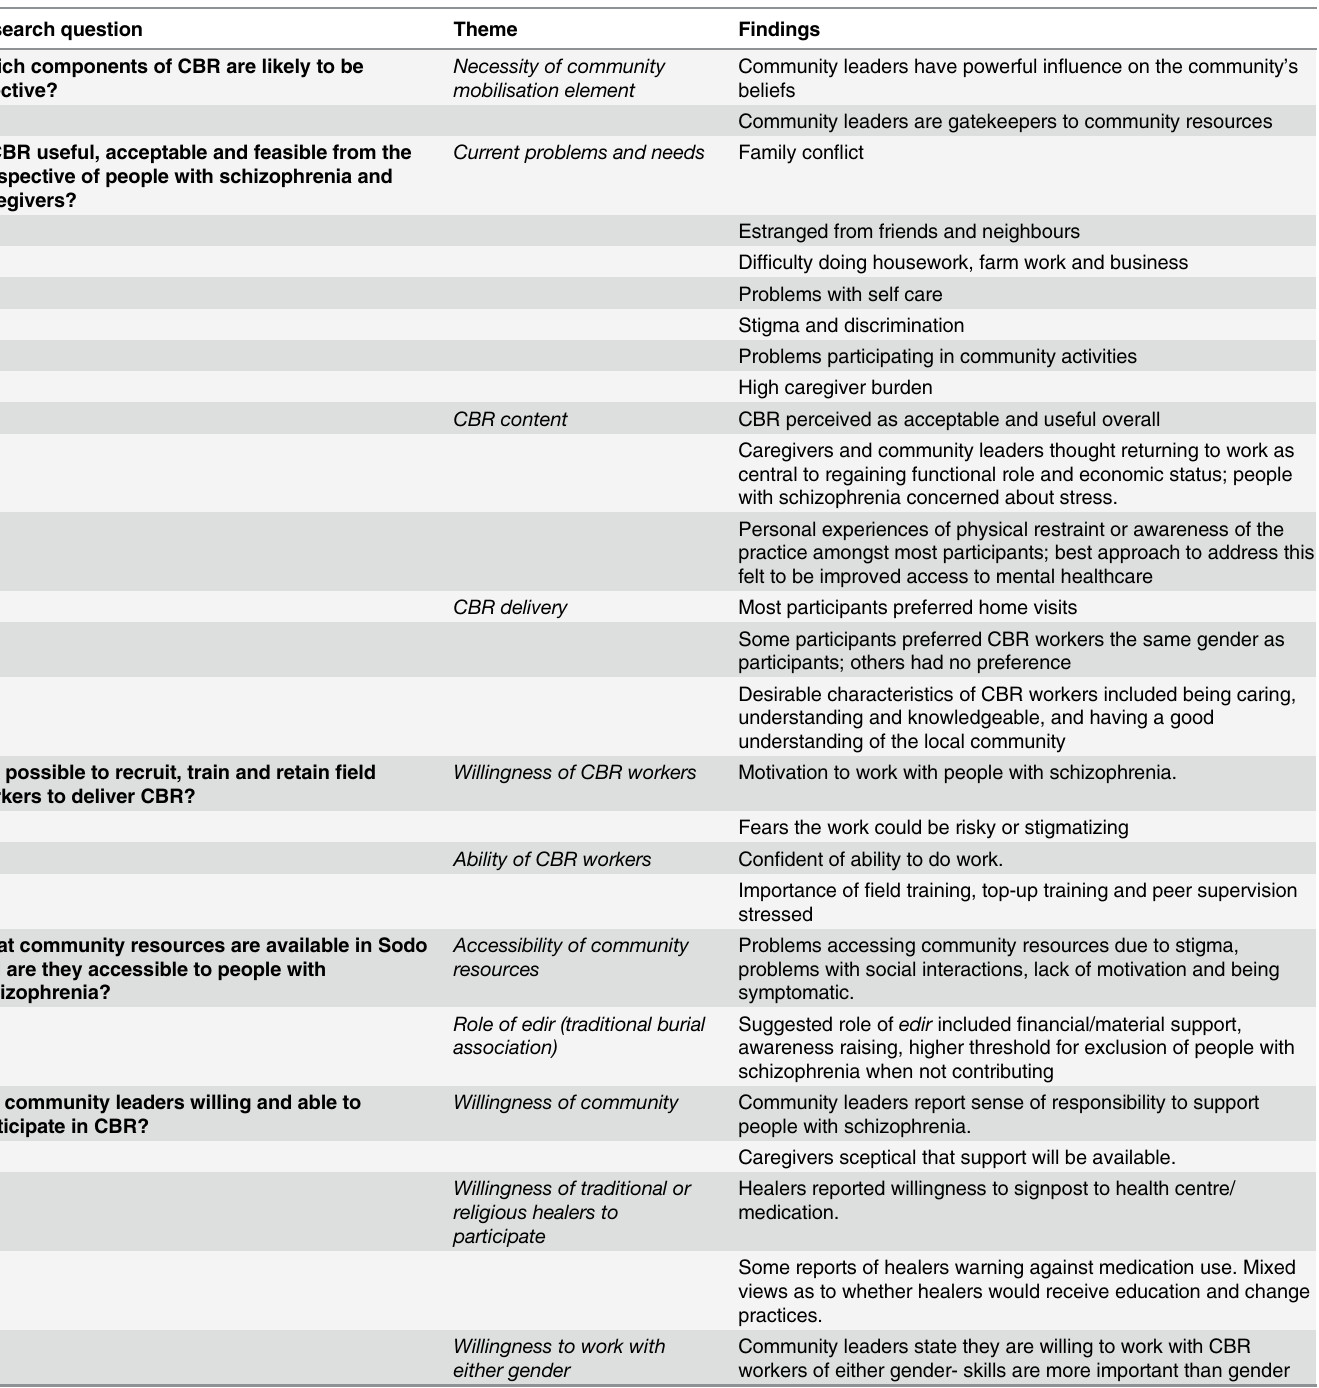
Table 2. Summary of findings from in-depth interviews and focus group